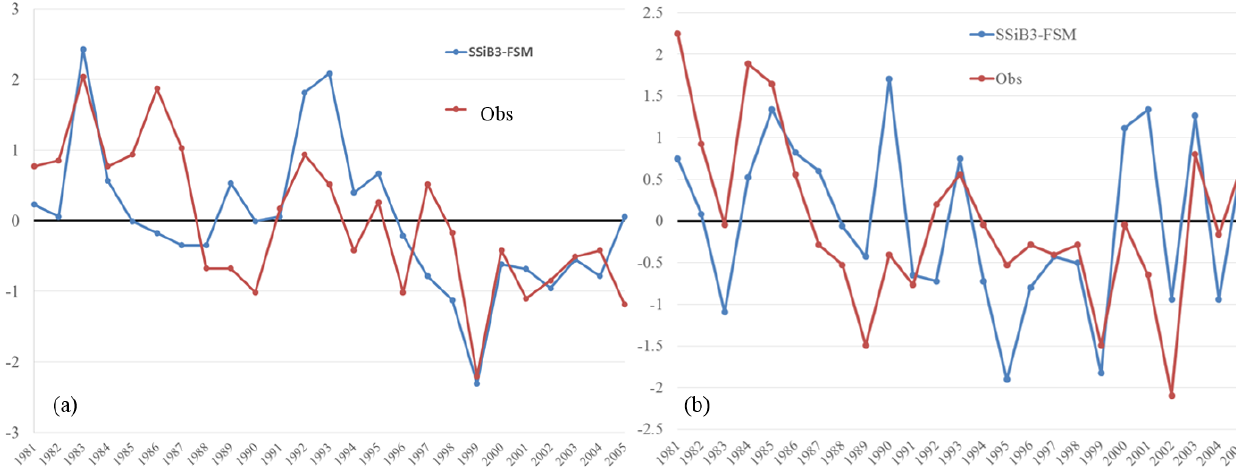
Figure 12. Normalization of MFD over (a) the TP and (b) NC for 1981–2005 for SSiB3-FSM and the